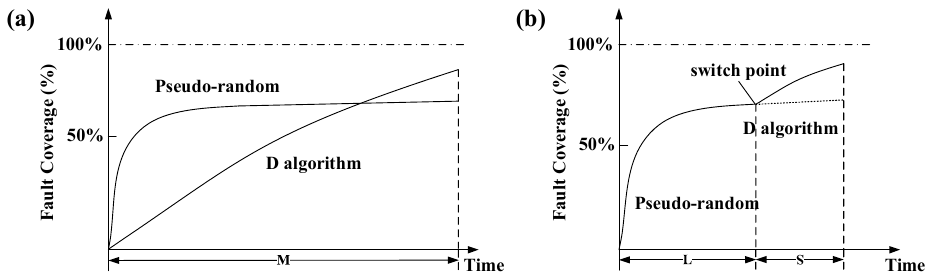
Figure 3. Relationship between the fault coverage and generation time of the algorithms. ( a ) with two independent algorithms, ( b ) with the time-varying pseudorandom disturbance algorithm